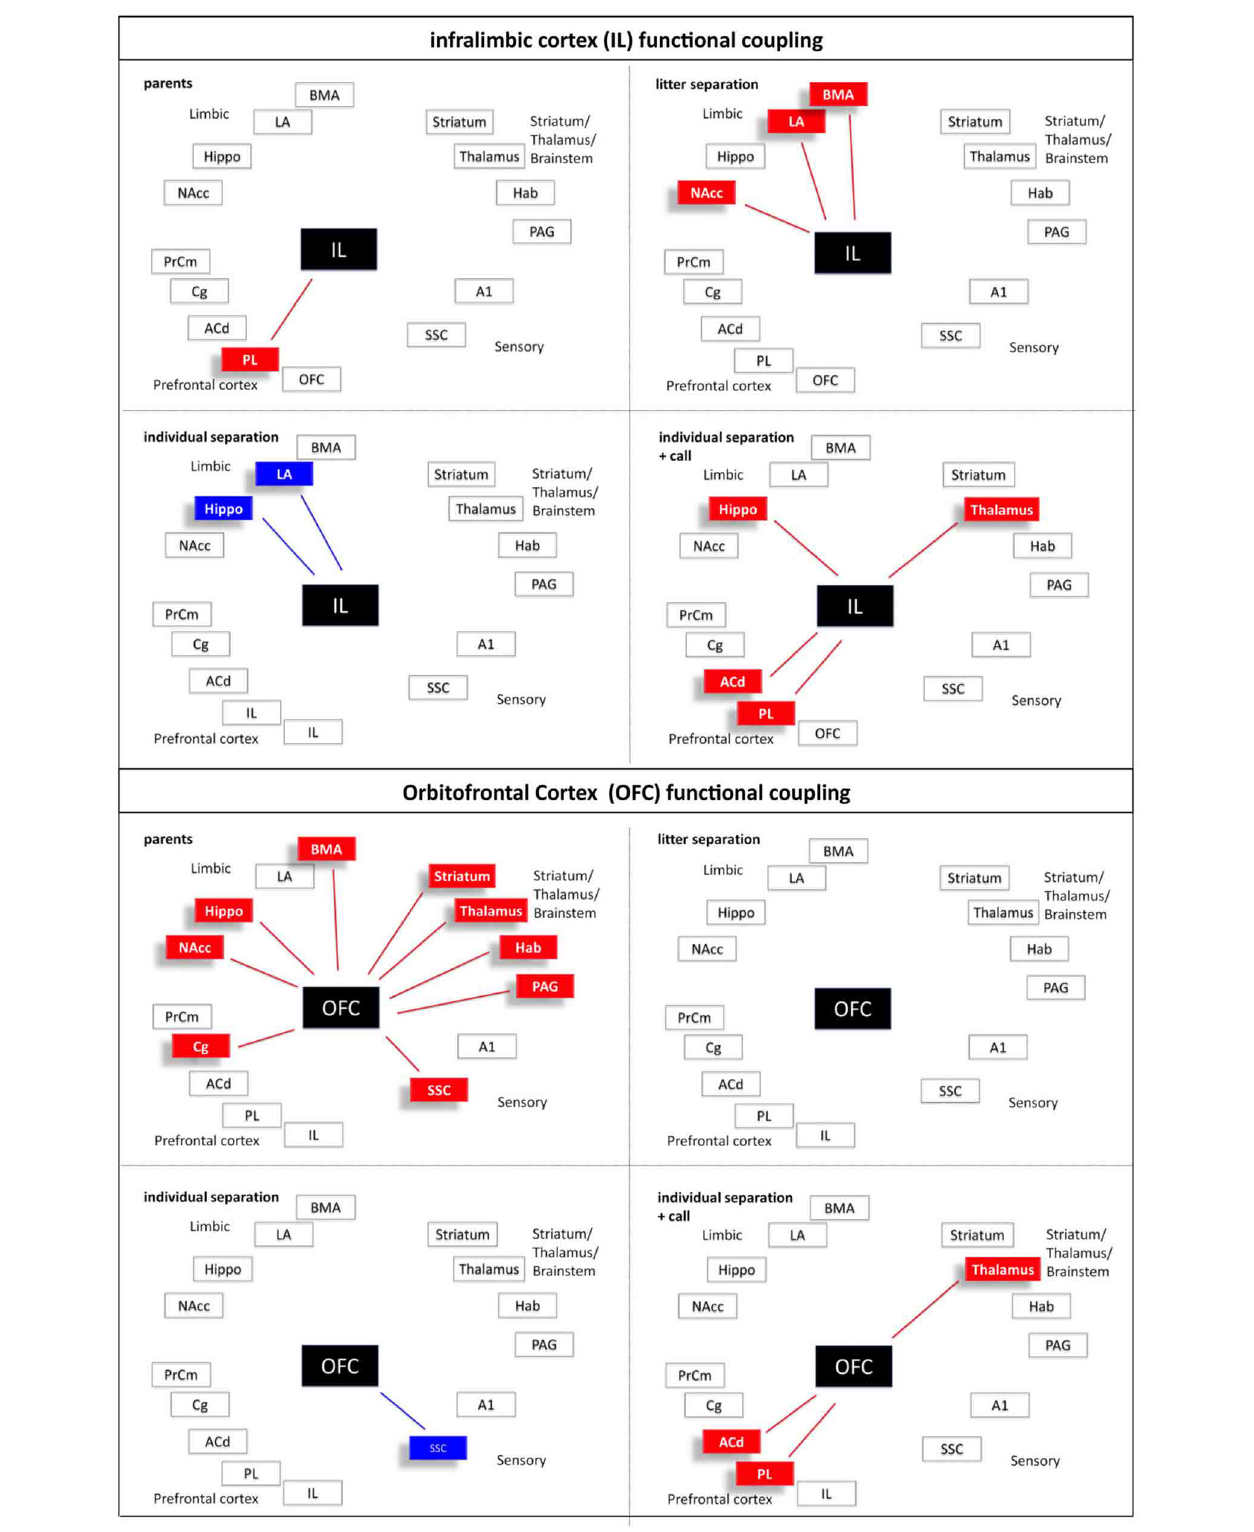
FIGURE 7 | Interregional functional coupling of the infralimbic (IL) and orbitofrontal (OFC) cortex under different stress conditions. Red color indicates positive, blue color indicates negative correlations ( p < 0 . 05).